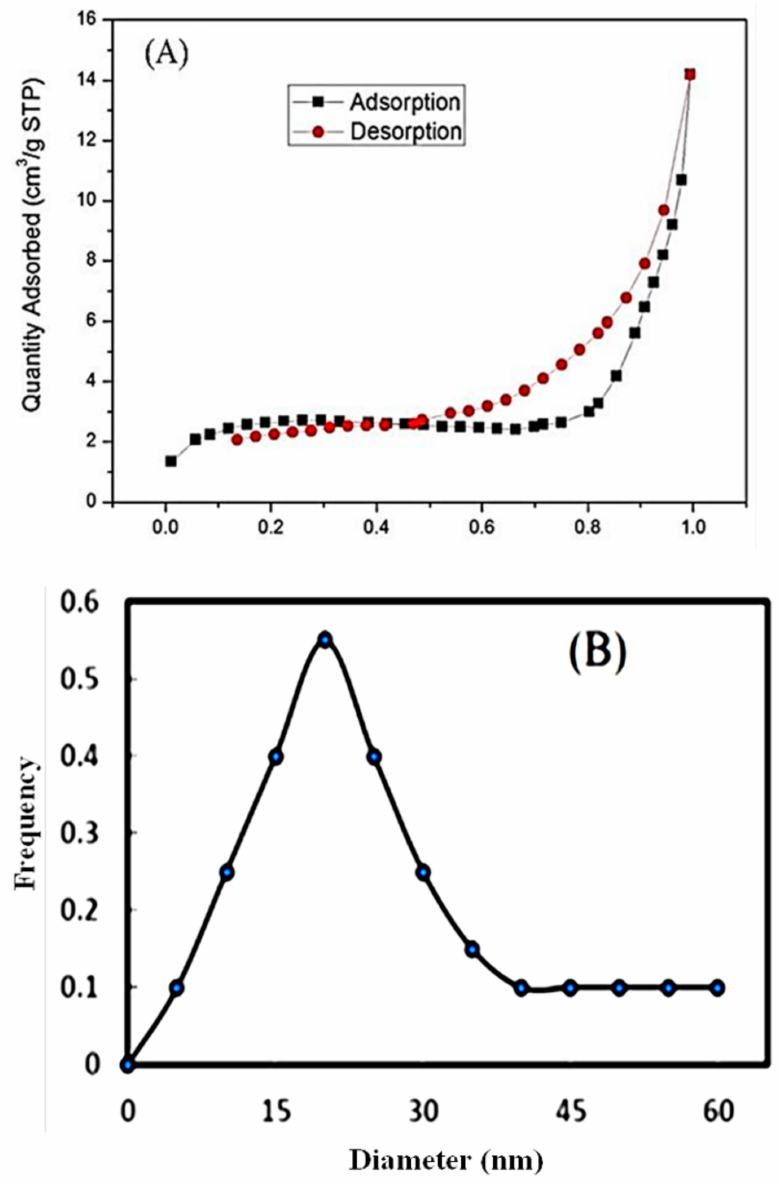
Figure 4. N 2 adsorption-desorption isotherm at 77.35 K, for CH/Zn@H 3 BTC ( A ) and the pore size distribution of CH/Zn@H 3 BTC ( B